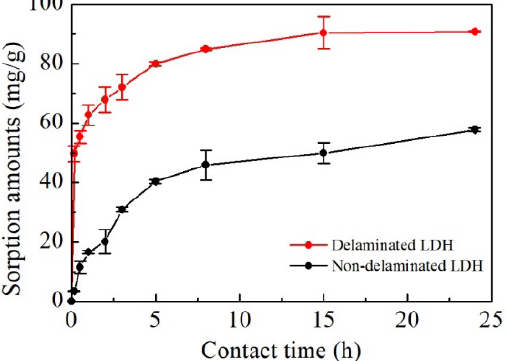
Figure 6. Reaction rates of tungstate sorption by delaminated and non-delaminated iron-based LDH.